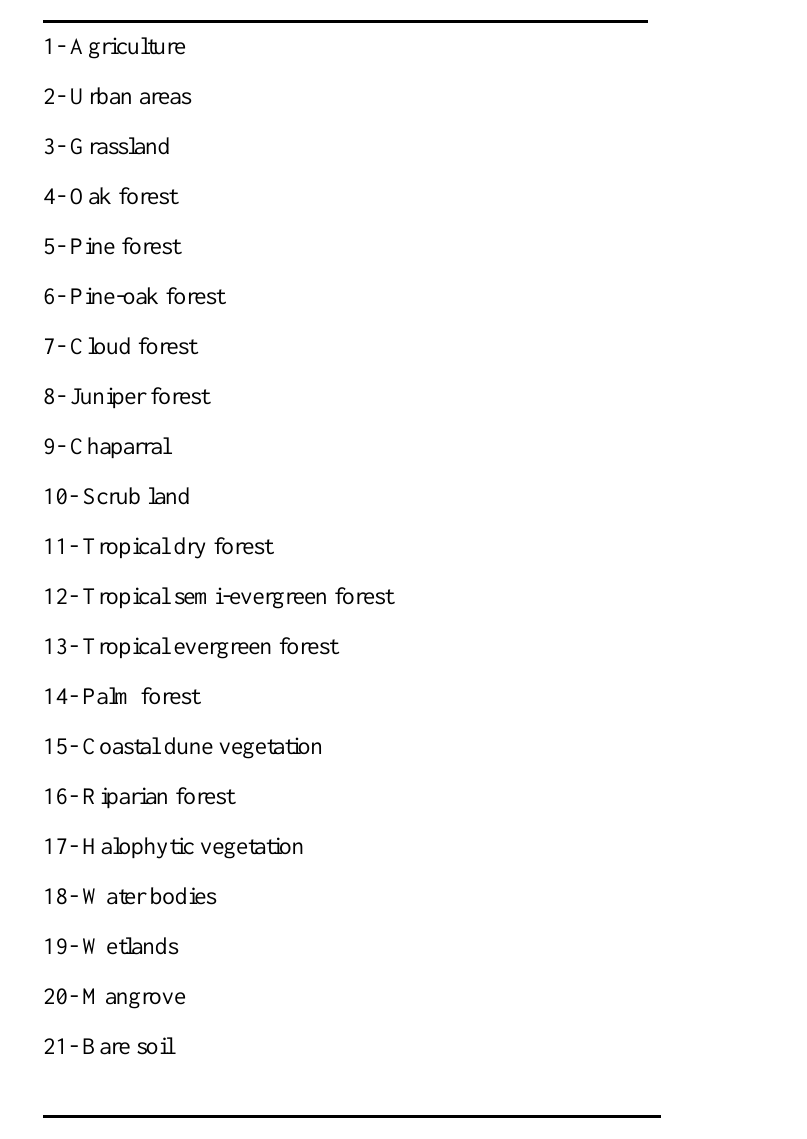
Table 3. Inventario Nacional Forestal 2000 (SEMARNAP 2000). Land use/land cover classes (LULC) used for analyzing landscape patterning associated to different land ownership regimes in northeastern